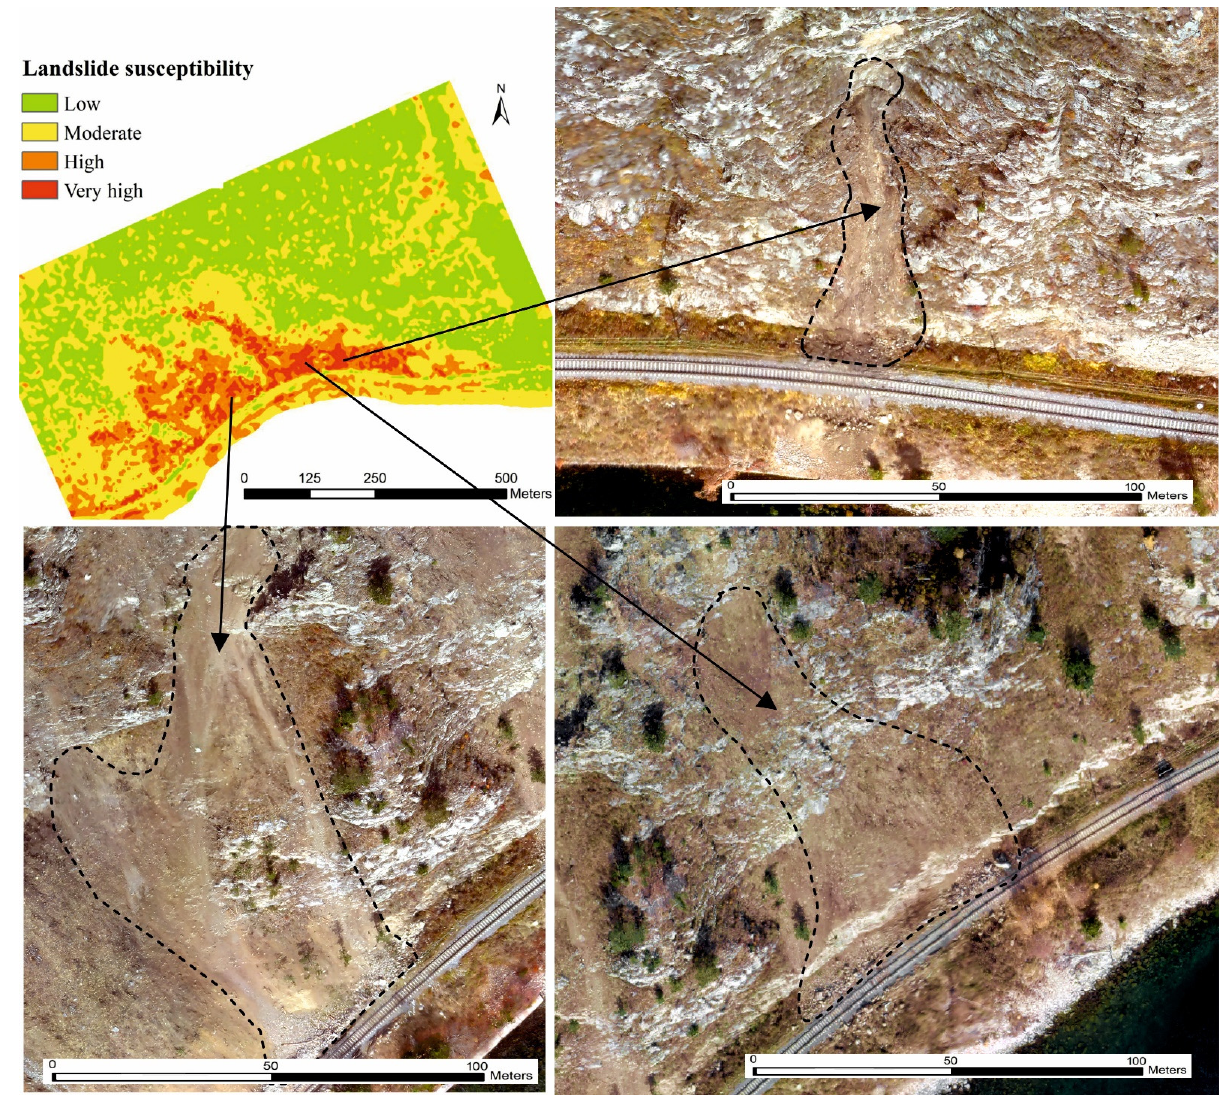
Figure 10. Existing landslides in the study area in 2020.